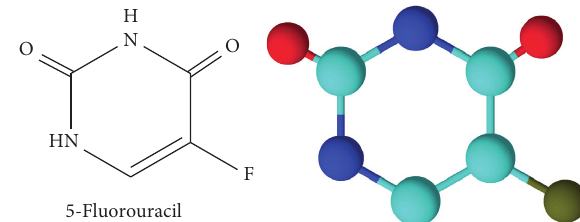
Figure 2: Chemical structure of 5-fluorouracil.